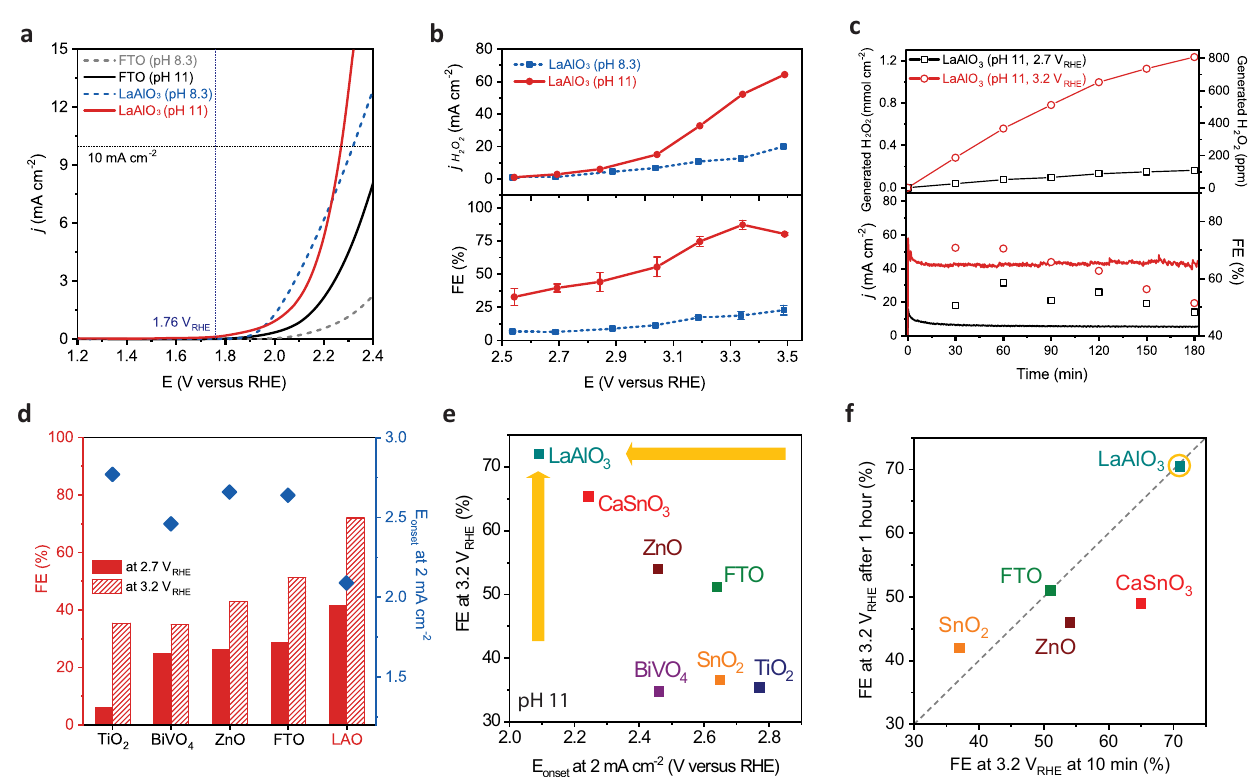
Fig. 5 | Electrochemical performance. a Linear sweep voltammetry curves of LaAlO 3 anodecomparedtoFTO/glasssubstrateintheelectrolyteof2MKHCO 3 (pH 8.3) and 4M K 2 CO 3 /KHCO 3 (pH 11). All curves are 95 % iR-compensated. b The calculated H 2 O 2 current density and selectivity of LaAlO 3 anode as a function of potential in different electrolytes, and c the generated H 2 O 2 amount, selectivity, andstabilityoftheLaAlO 3 anodeatdifferentpotentials,2.7and3.2Vvs.RHEfor3h. d ComparisonofFaradaicef fi cienciesatdifferentpotentialsandonsetpotentialsto